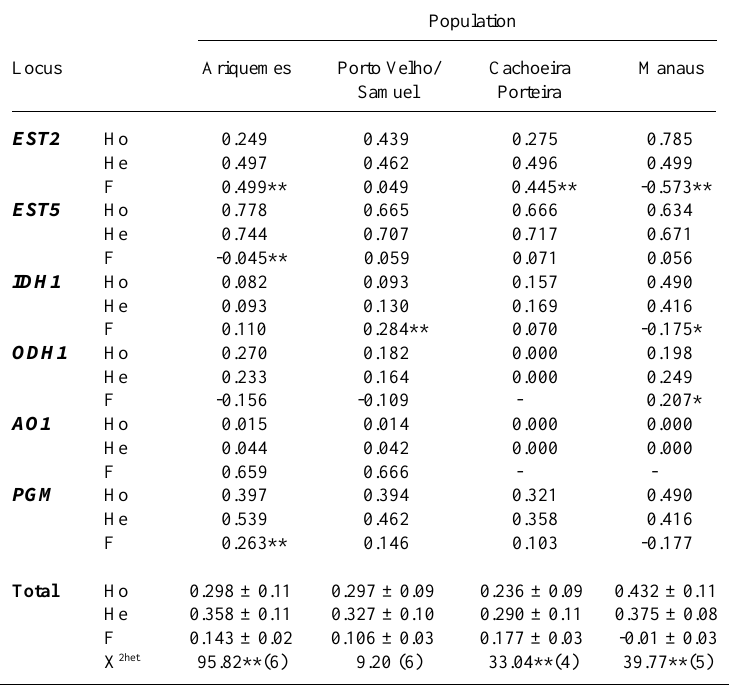
Table III - Observed (Ho) and expected (He) heterozygosity and respective Wright F- value for each locus in the Anopheles darlingi populations